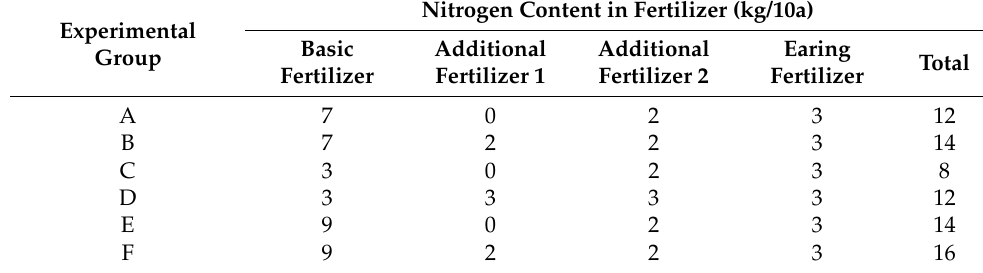
Table 1. The description of fertilization details in the field.